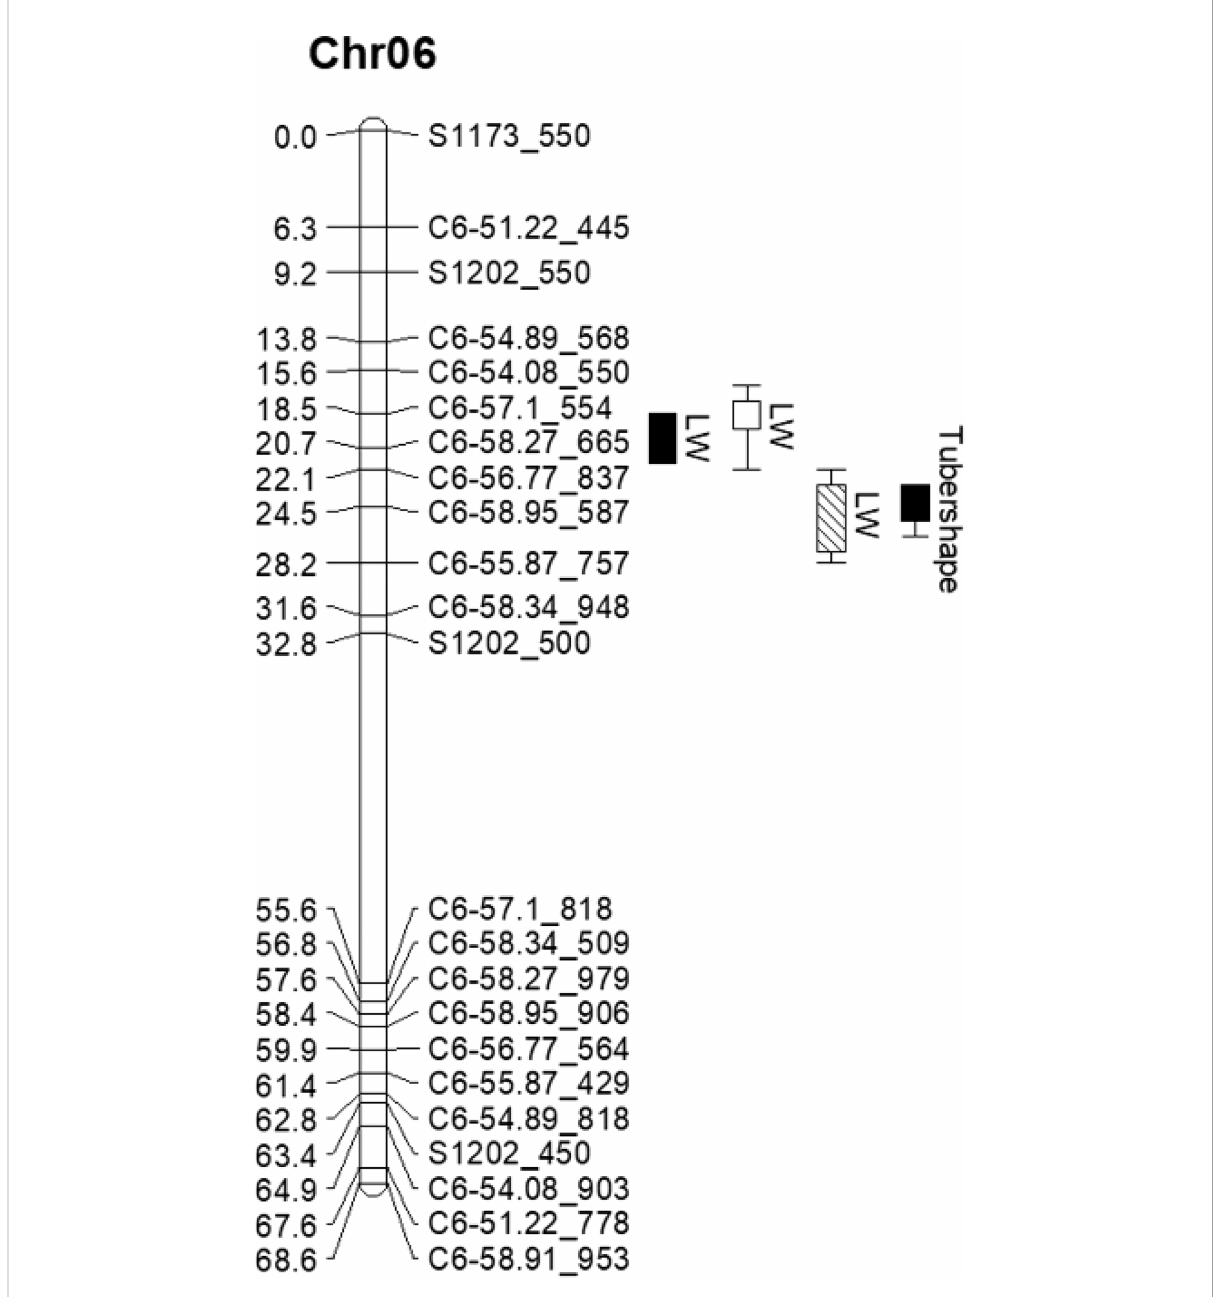
FIGURE 4 Identi fi cation and validation of the QTL Tscha6 for tuber shape in potato chromosome 6. On the linkage map, the maker locations are shown as cumulative distances in cM. The right side of the map shows the tuber shape QTL. Bars with different fi ll styles represent the tuber shape QTL in different environments. The solid bars represent environment I, the empty bar represents environment II, and the lower diagonal fi ll bar represents environment